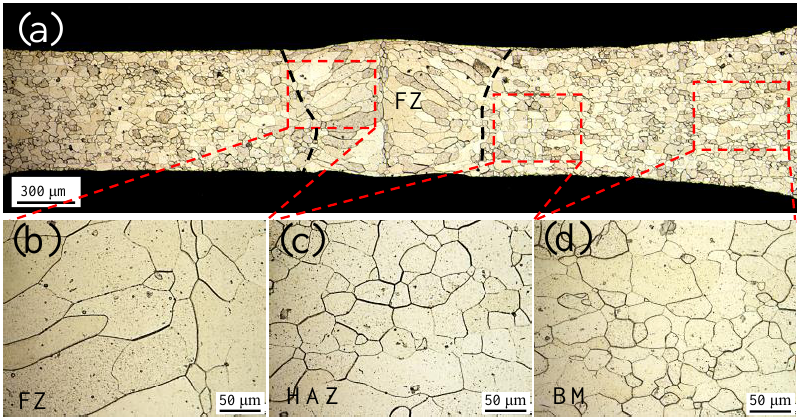
Figure 10. ( a ) Metallographic picture of the cross section of the joint welded using parameters 7 (0.5) #; ( b – d ) Magnified pictures of the FZ, HAZ, and BM, respectively.